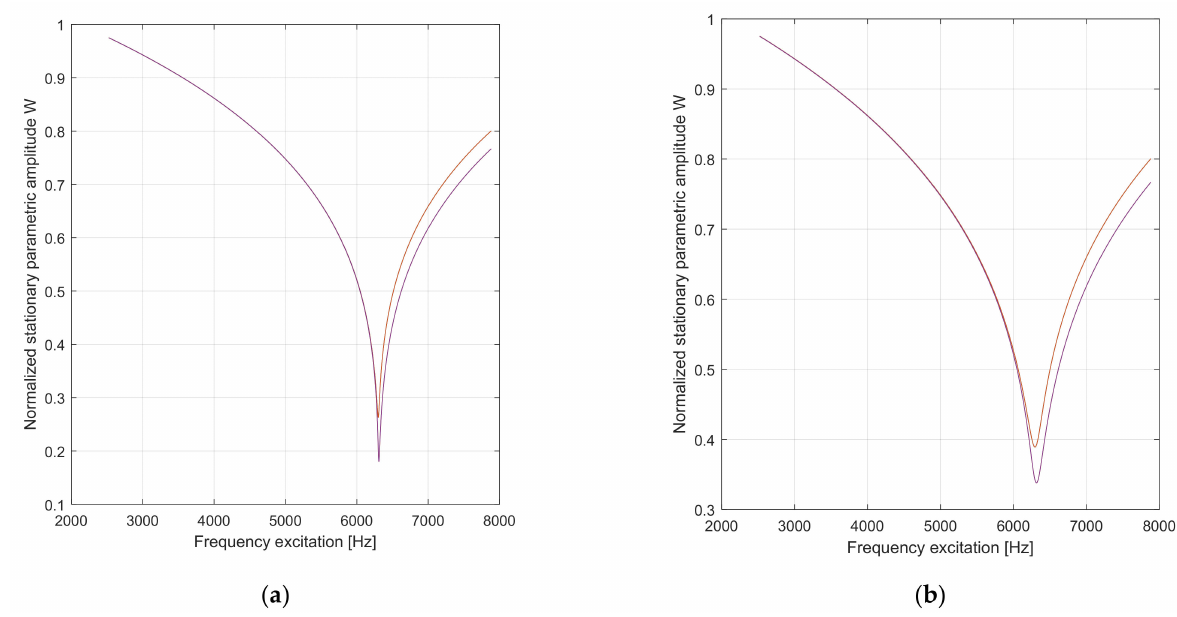
Figure 15. Normalized stationary parametric amplitude W of the bowl for χ nB = 0.10, where